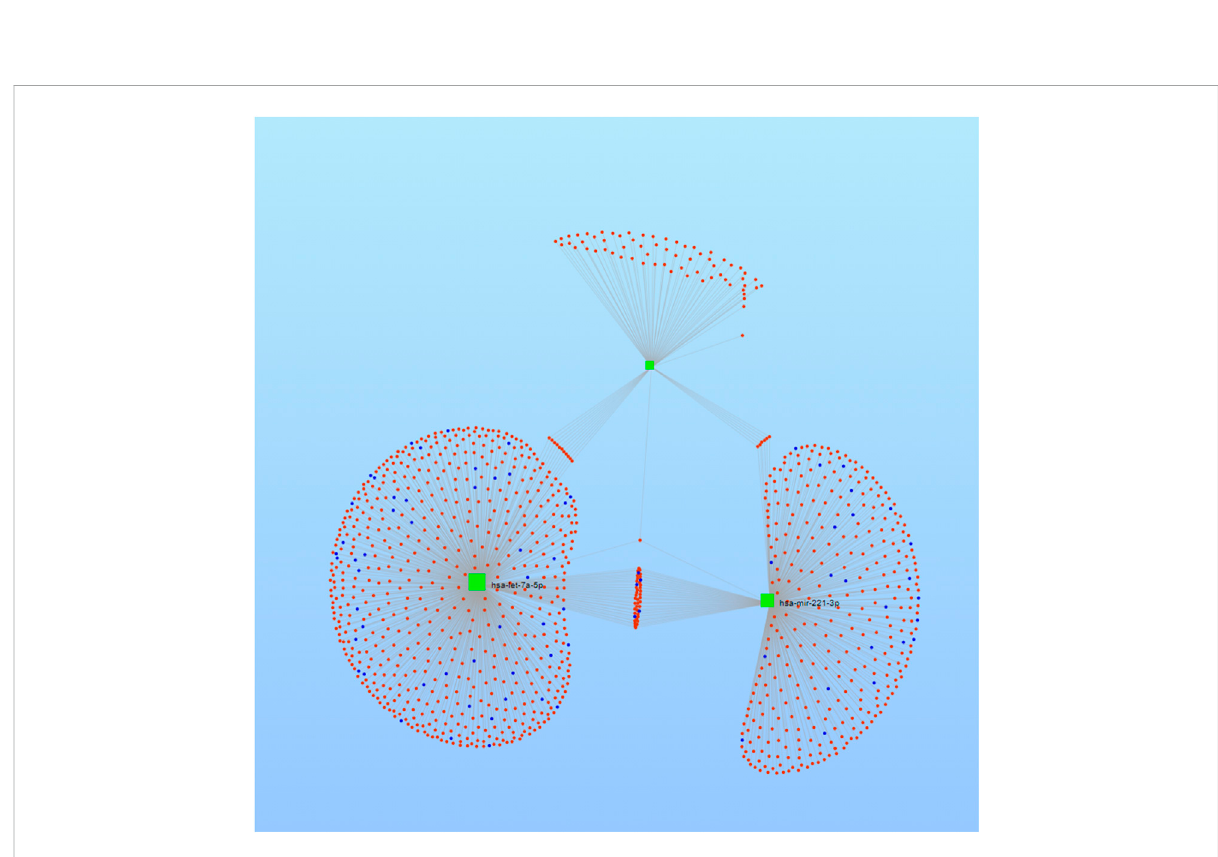
FIGURE 8 Network map of miRNA target